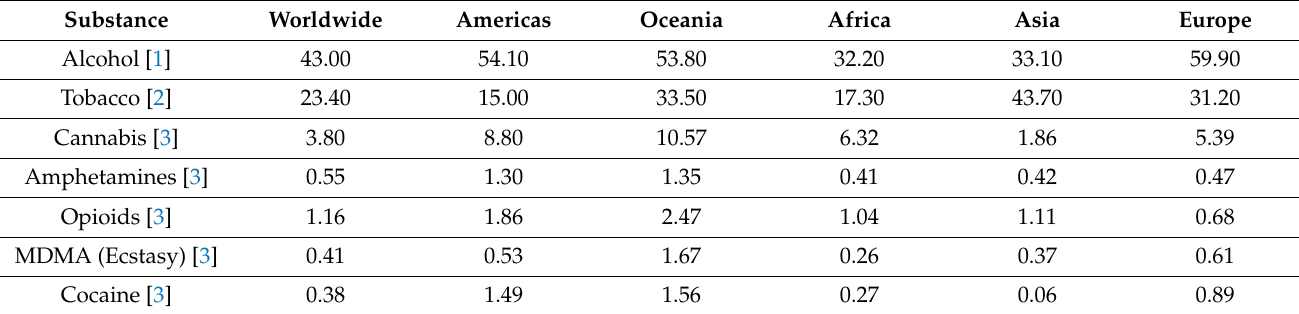
Table 1. Consumption of the main drugs of abuse (% of the 15-year-old and above population). Substance